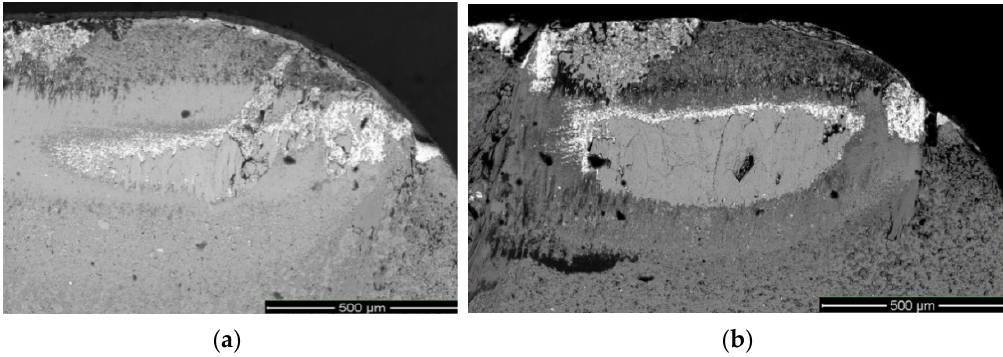
Figure 7. Contact pads on the rake faces of the carbide tools with coatings ( a ) Ti-TiN-(Ti,Cr,Mo,Al)N and ( b ) (Ti,Al)N after 16 min of cutting.